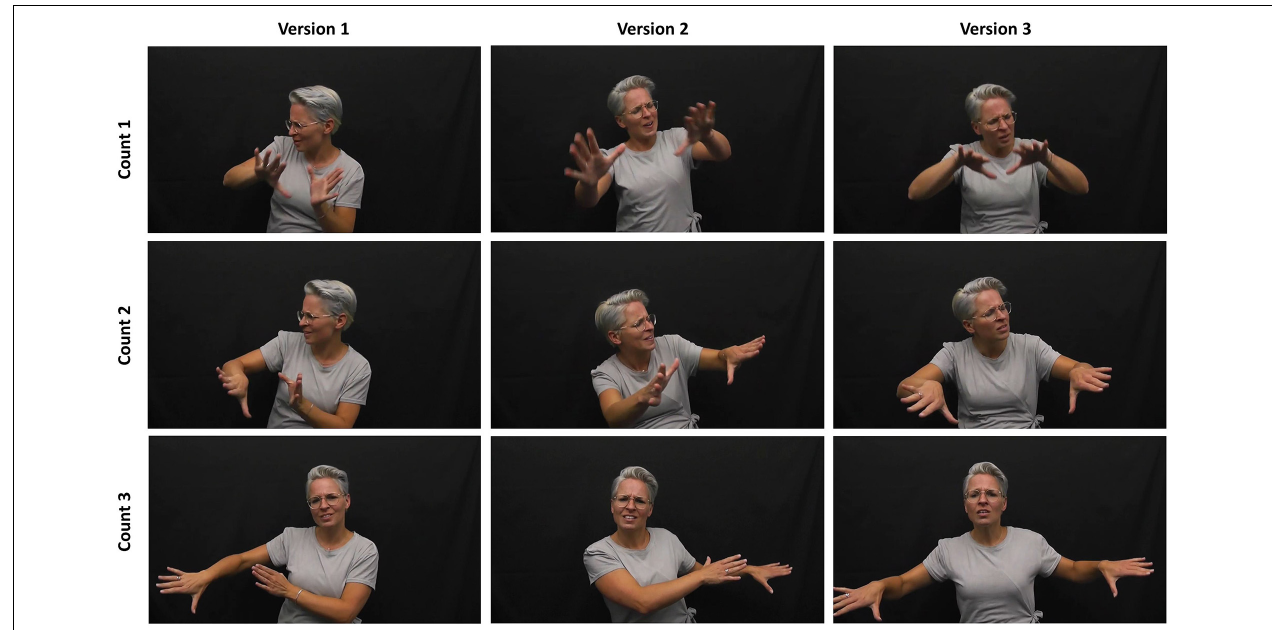
FIGURE 1 | Embodied gestalt construction of meaning, and use of extended time and space—“[drown them] out” versions 1, 2, and 3—at 00:56, 02:11 and 03:10, respectively (Stolk: This is Me—Greatest Showman,